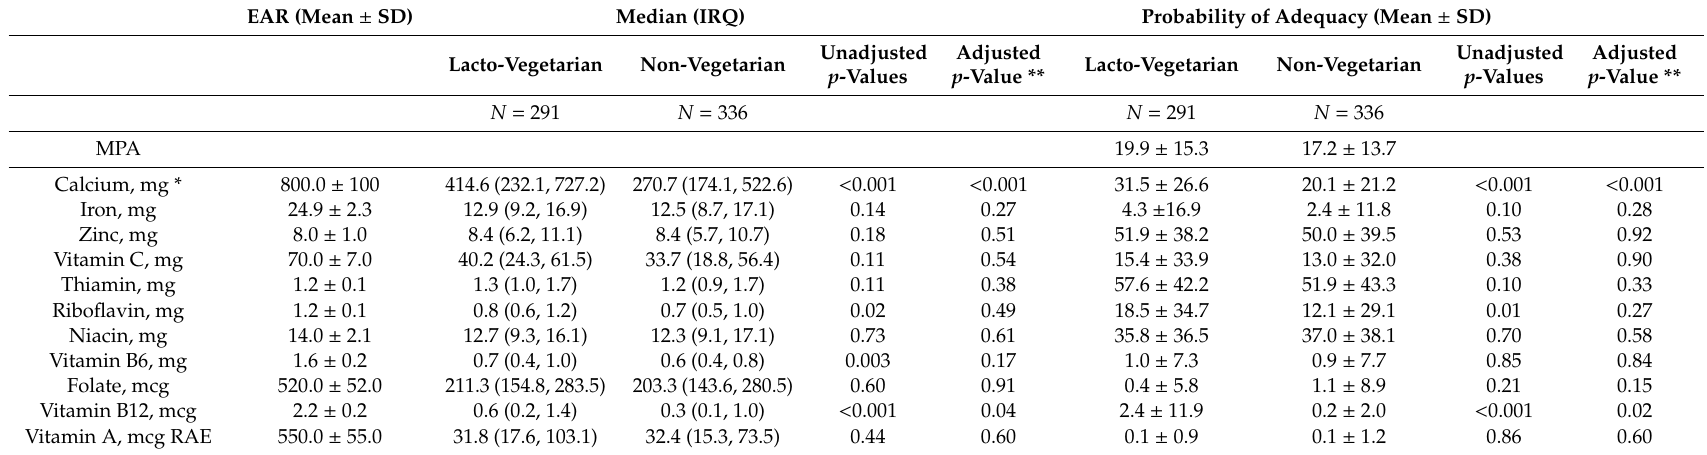
Table 3. Dietary intakes of selected micronutrients among lacto-vegetarian and non-vegetarian pregnant women in Uttar Pradesh,